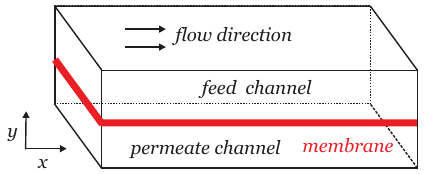
Figure 1. Membrane system illustration.